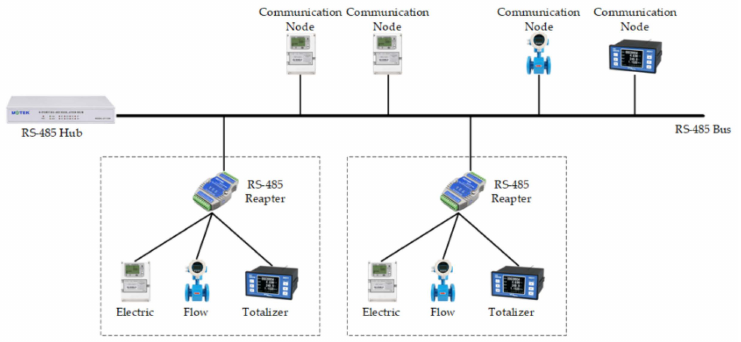
Figure 2. Communication network